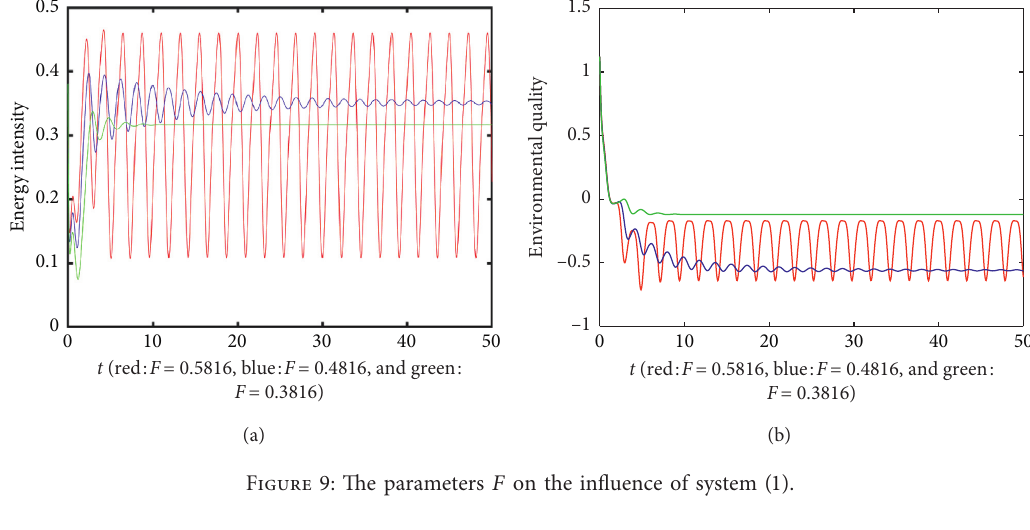
Figure 9: The parameters F on the influence of system (1).